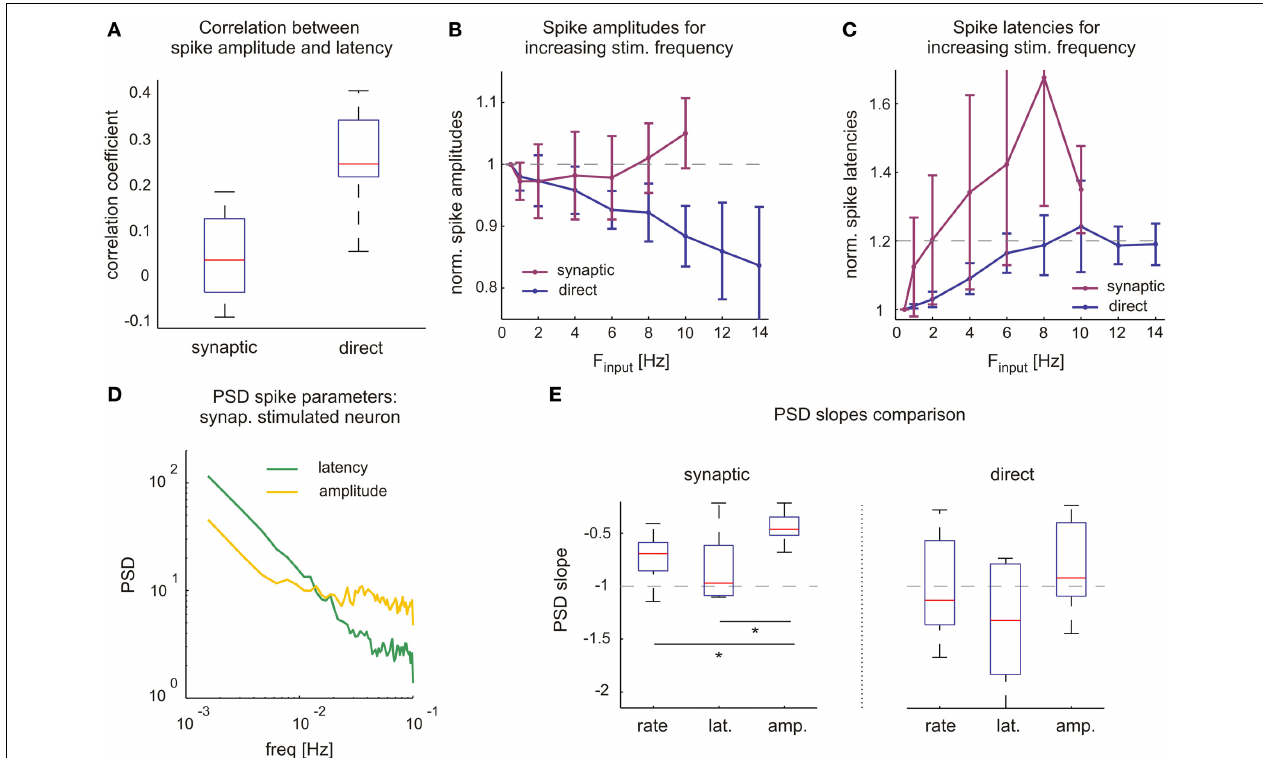
FIGURE 6 | Synaptic processes are key determinants of rich response dynamics. (A) Unlike in synaptic mediated responses, direct response spike amplitudes and latencies are correlated. Spike parameters used from high frequency stimulation experiments shown in (C,D) ( Figure 5 ). Box plot (horizontal red line, median; blue box, 25th–75th percentile). (B) In contrast to synaptic, the direct mediated spike amplitudes decrease significantly with increasing stimulation frequencies. Means and SDs of spike amplitudes belonging to the same neurons, shown in (B,C) , ( Figure 4 ) and therefore contain different counts of data points for each stimulation frequency. In order to compare across several neurons, averaged amplitudes of each neuron are normalized by its average at 0.5Hz. (C) Direct mediated spike latencies approach to and fluctuate